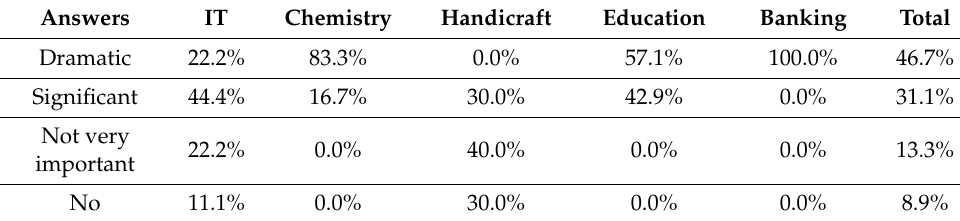
Table 6. Evaluation of the role of reputation for the success of a